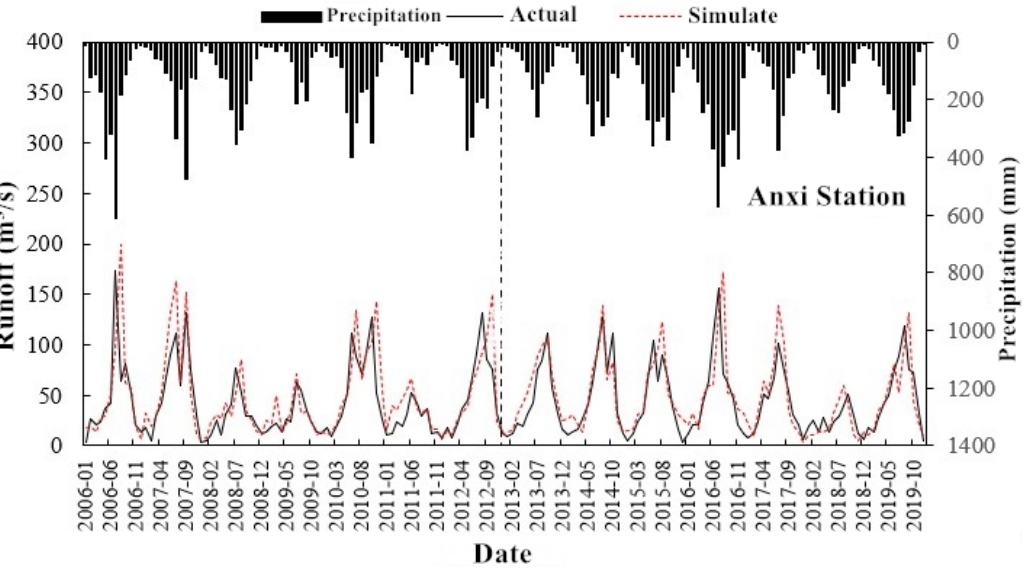
Figure 8. Comparison of measured and simulated runoff data for the Anxi hydrological station in the Jinjiang watershed. Table 2. Simulation results for the calibration and validation periods for three hydrological stations in the Jinjiang watershed.